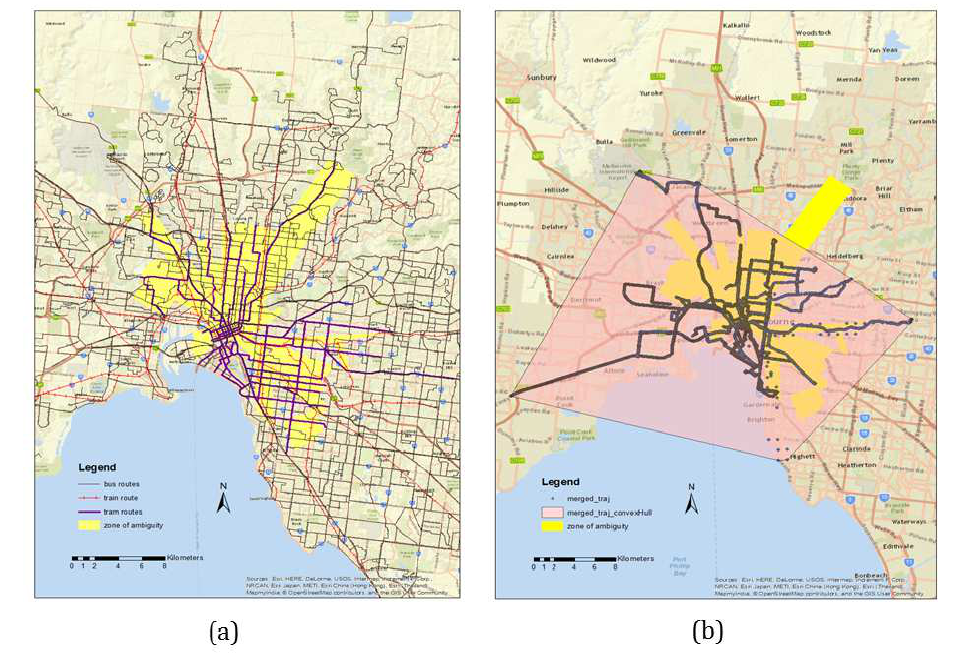
Figure 8. Map ( a ) shows the zone of ambiguity with a significant overlap between different public transport routes; Map ( b ) shows the overlap between the convex hull of the trajectory data set (Data set 1) and the zone of